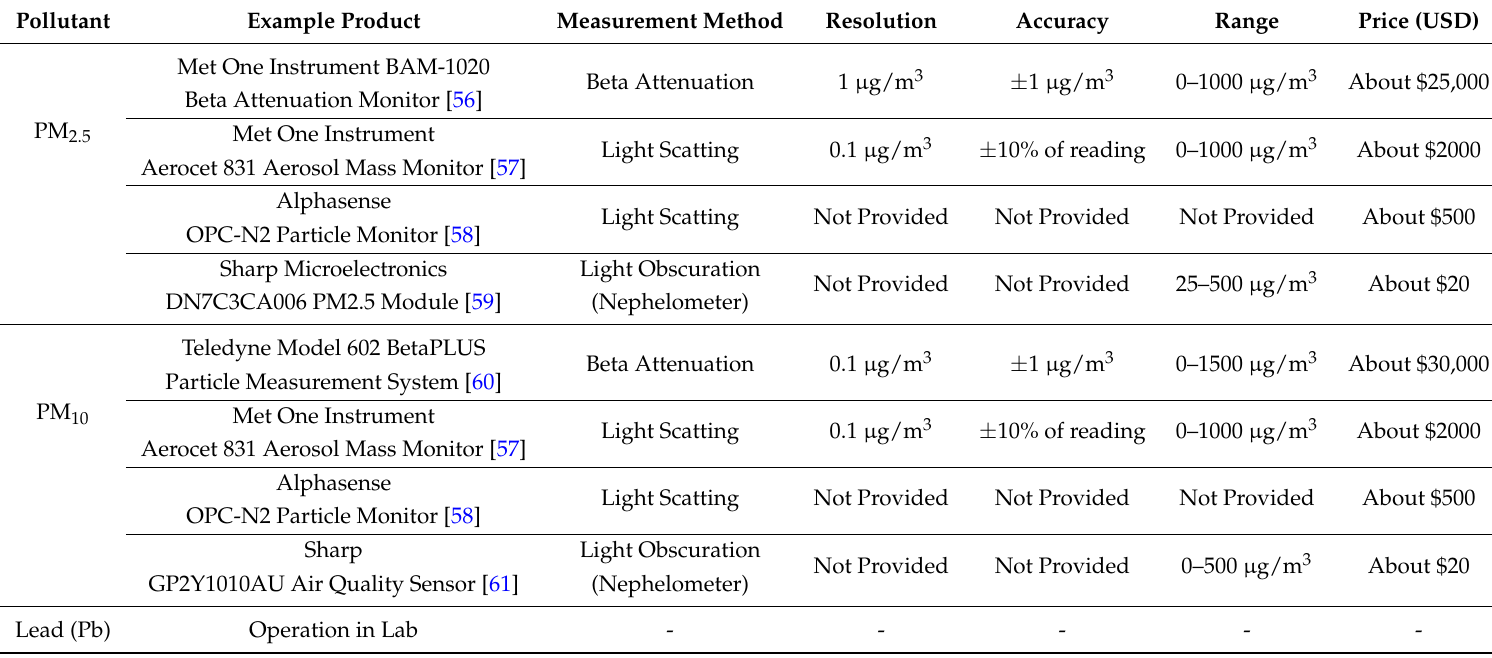
Table 5. Instruments used in air quality monitoring systems (Part